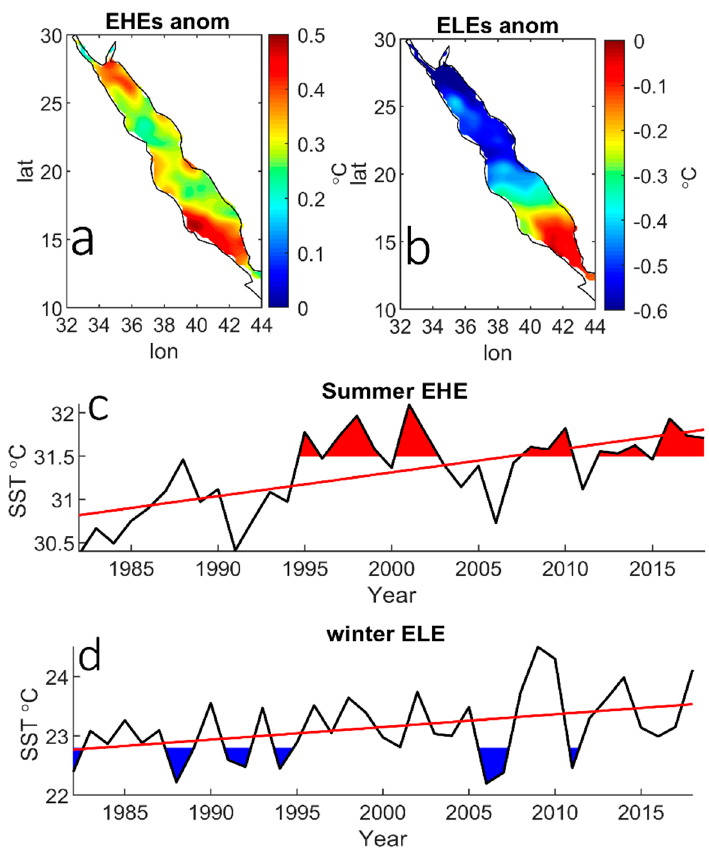
Figure 3. Spatial SST anomalies in °C for EHEs and ELEs ( a , b ), and the time series of the highest (lowest) 5% SST events including EHEs (ELEs) superimposed with their corresponding linear trends ( c , d ).